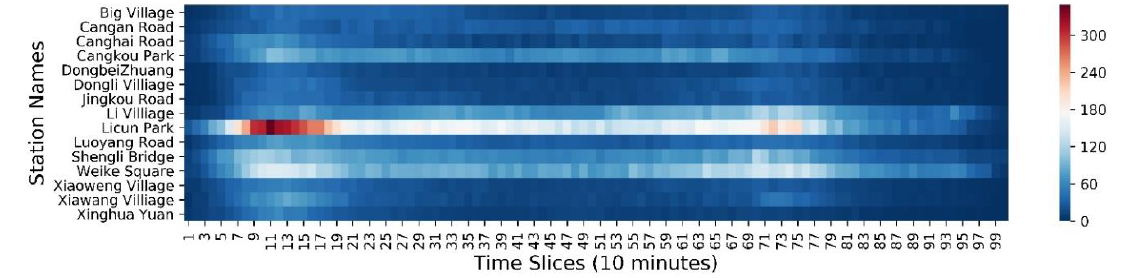
Figure 7. A comparison diagram of passenger flow distribution at key regional stations.